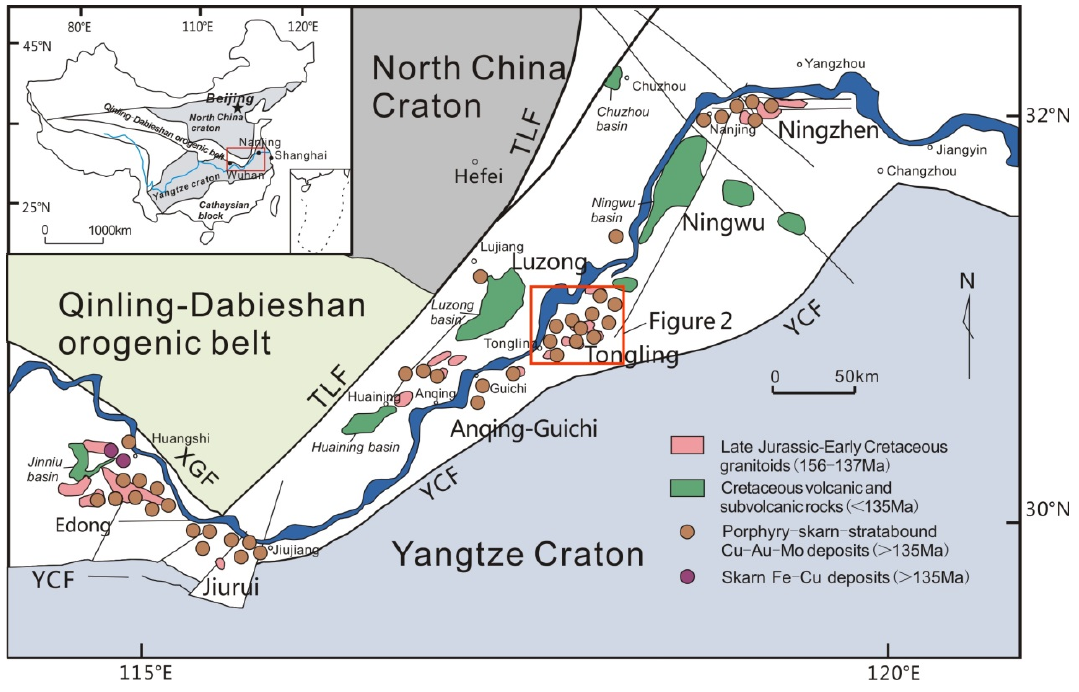
Figure 1. Geological map showing the location of the Tongling ore district, and related porphyry–skarn–stratabound Cu-Au-Mo (>135 Ma) deposits along the Middle–Lower Yangtze River Valley Metallogenic Belt [16]. Faults: TLF—Tancheng–Lujiang fault, XGF—Xiangfan–Guangji fault, YCF—Yangxing–Changzhou fault.